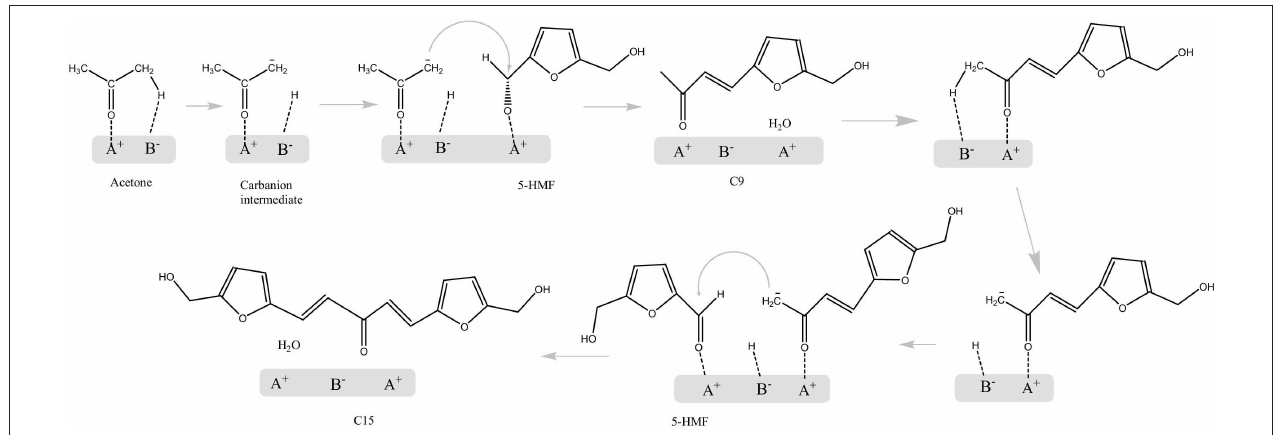
FIGURE 13 | The aldol condensation mechanism of HMF and acetone. Reprinted from Cueto et al. (2017), with permission from